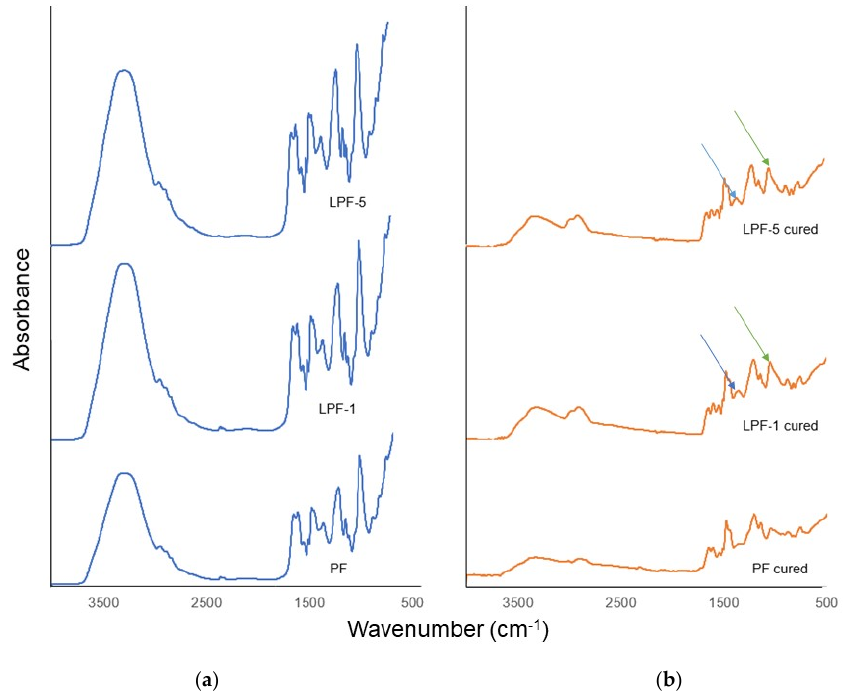
Figure 3. FTIR spectra of uncured ( a ) and cured ( b ) resins. Note: deformation vibration of bonds – CH of the aromatic ring (green arrow); stretching vibration of C–O (blue arrow).